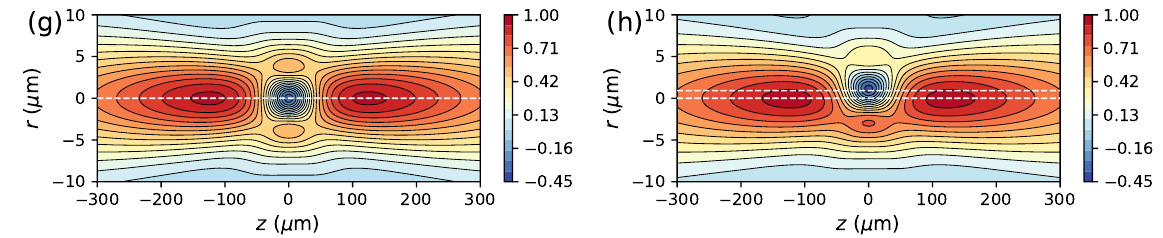
Figure 4. ( a – d ) Calculated bichromatic potentials for 138 Ba + and ( e – h ) for 87 Rb. Potentials with (without) a relative radial displacement ∆ r = w 0 /4 (indicated by the white dashed lines) between the NIR and VIS OTDs are depicted on the right (left). ( a , b , e , f ) show results for matched 1/ e 2 beam waist radii of w 0 = 3.7 µ m. The case where the VIS ODT waist is w 0, VIS = 2 w 0 is shown in ( c , d , g , h ). The depth of the potentials U Ba , Rb / k B (in mK) is represented by false colours. For 0 138 Ba + , the effect of ∆ r on the potential is negligible. In contrast, for 87 Rb the same displacement drastically changes the potential landscape, shifting the trap minimum and increasing U Rb . The impact of the relative displacement is slightly 0 mitigated for the configuration with w 0, VIS = 2 w 0